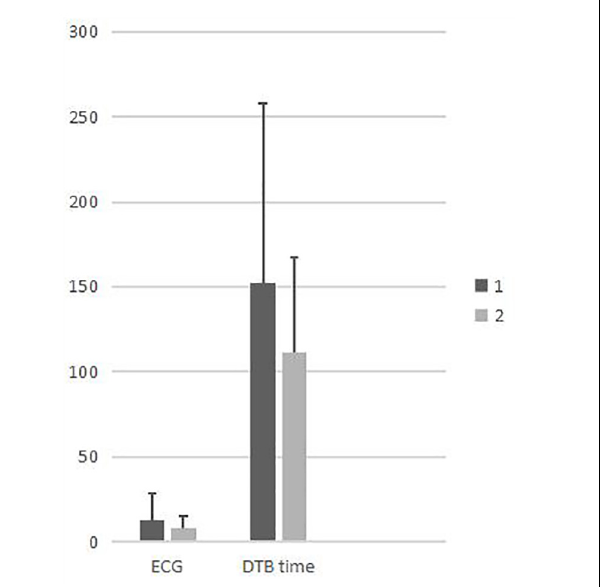
TABLE 1 | Total number of emergency visits and STEMI patients in 2016–2020.